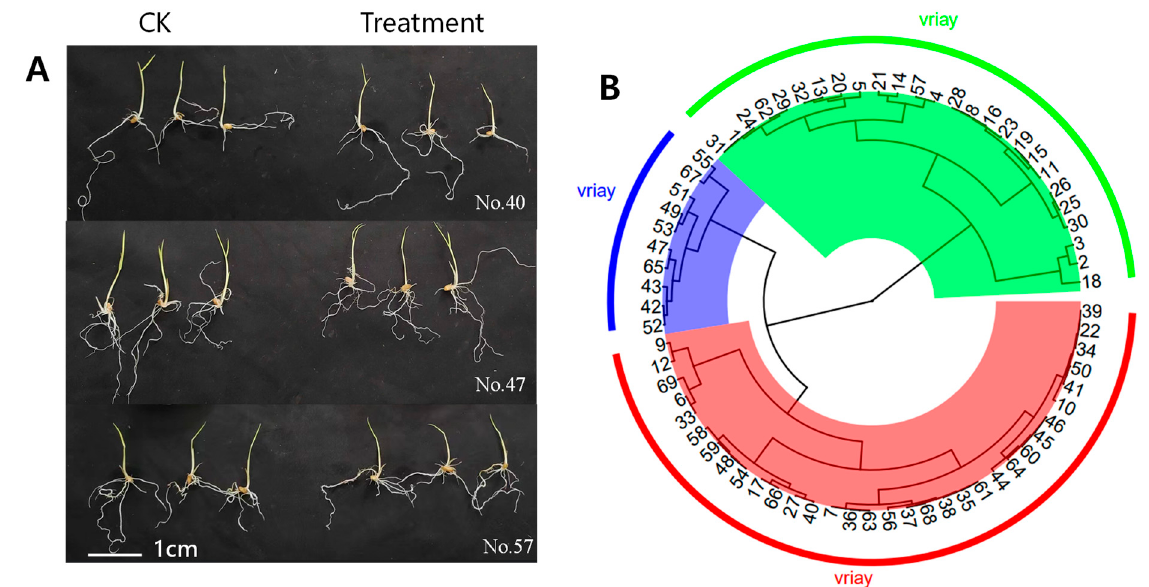
Figure 1. The growth of rice treated with 20% concentration of PEG-6000 solution ( A ) and cluster analysis of 69 varieties at germination stage in 2019 ( B ). The colors represent the classification of the different drought-resistant varieties, Green for strongly sensitive varieties. Red for tolerant varieties. Blue for strongly tolerant varieties.